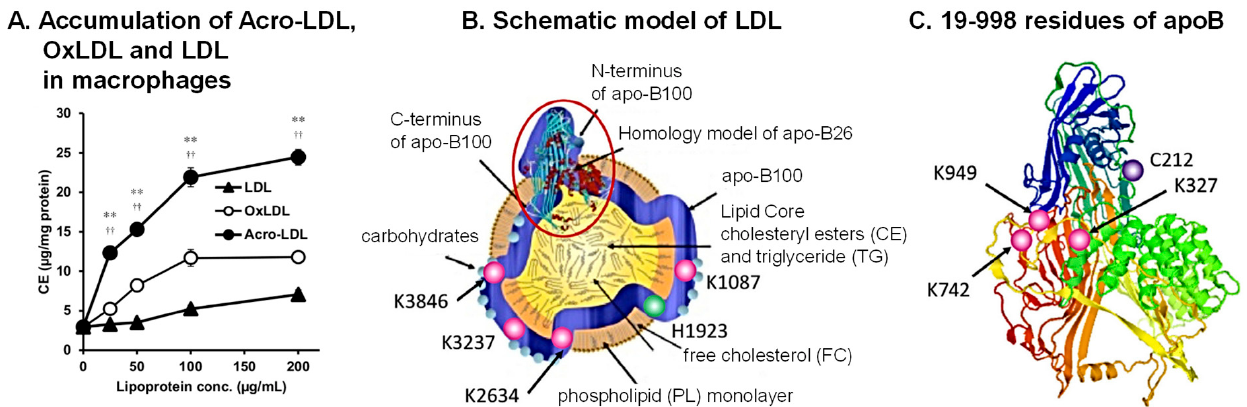
Figure 4. Preferential accumulation of acrolein-conjugated LDL in macrophages and identification of acrolein-conjugated amino acids in ApoB100. ( A ) Acro-LDL, OxLDL, and LDL were accumulated dose-dependently in THP-1 macrophages. ** p < 0.01 vs. OxLDL and †† p < 0.01 vs. LDL. Schematic model of Acro-LDL particle ( B ) and 3D structure of peptide 19-998 of ApoB100 ( C ). Adapted with permission from Ref. [43]. 2009 Springer Nature. Acrolein-conjugated amino acids are shown. Adapted with permission from Refs. [40,41]. 2013 and 2021 Elsevier.